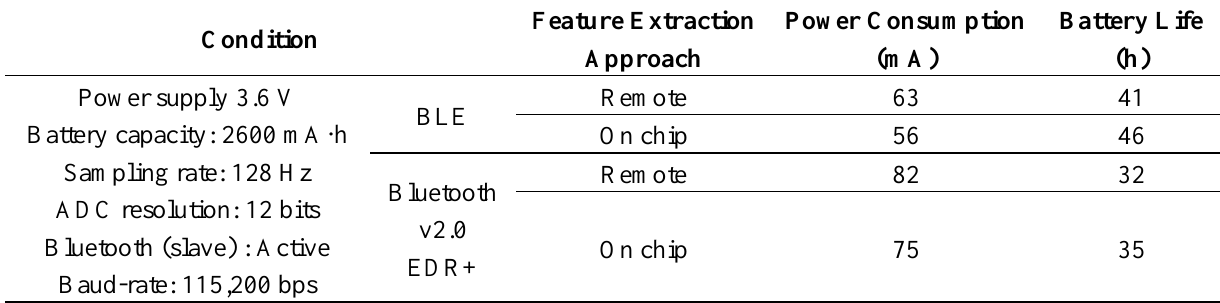
Table 2 . Results of the headset battery life comparison of remote and local feature